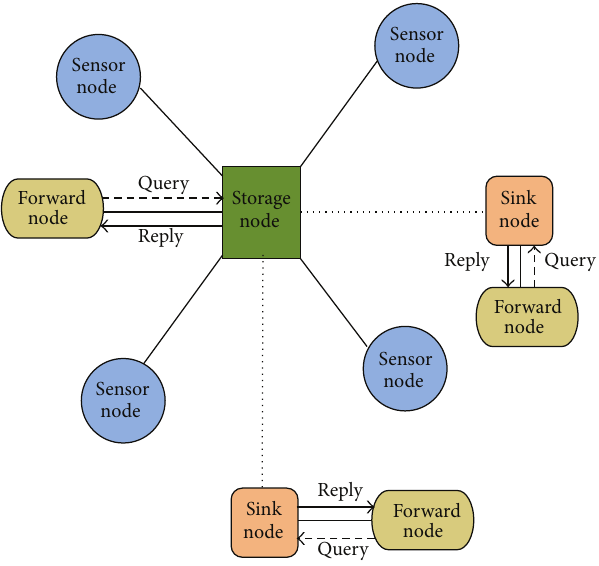
Figure 1: Wireless sensor network